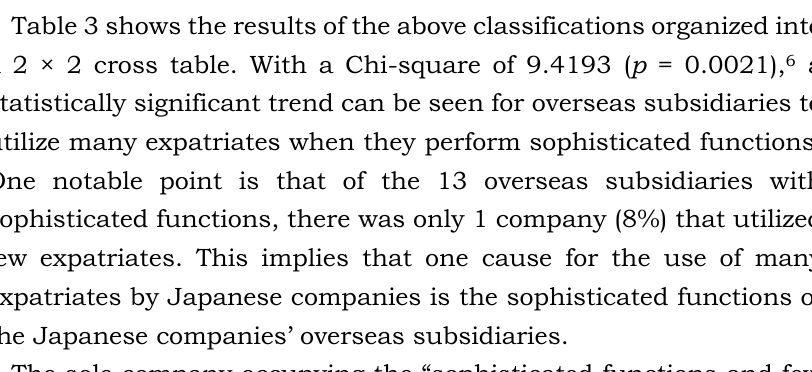
Table 3. Contingency table of expatriates and functions) Expatriates of an overseas subsidiary Few (less than average) 8 1 9 Many (more than average) 4 Total